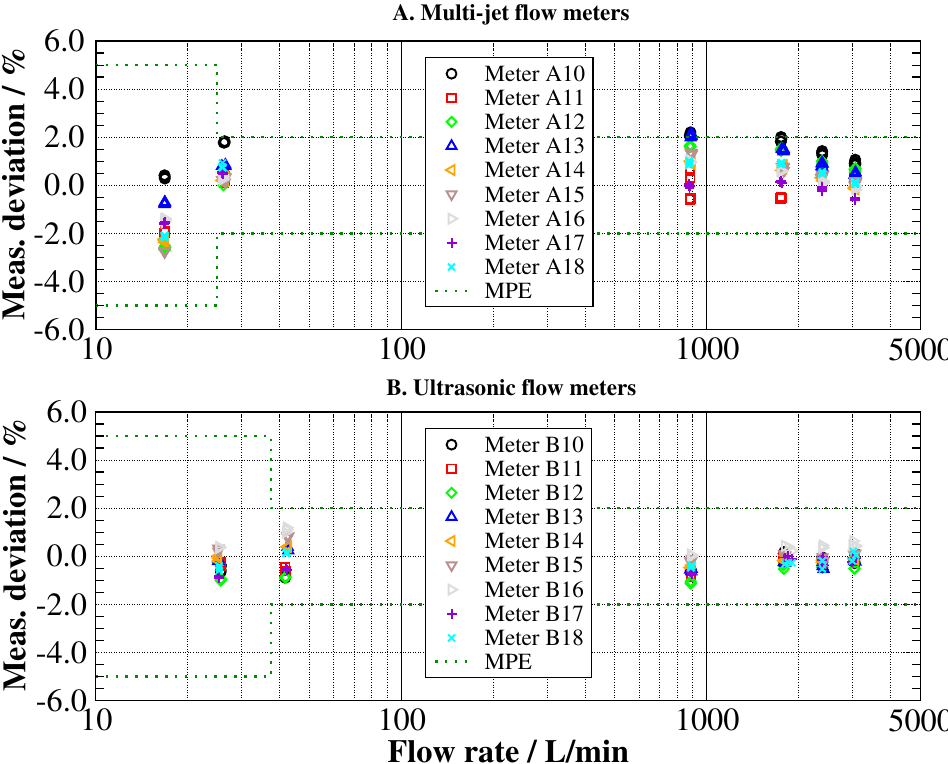
Figure 5. Top: ( A ). Calibration results of the B meters multi-jet cold water meters before the pH value tests; Below: ( B ). Calibration results of the Kamstrup ultrasonic cold water meters before the pH value